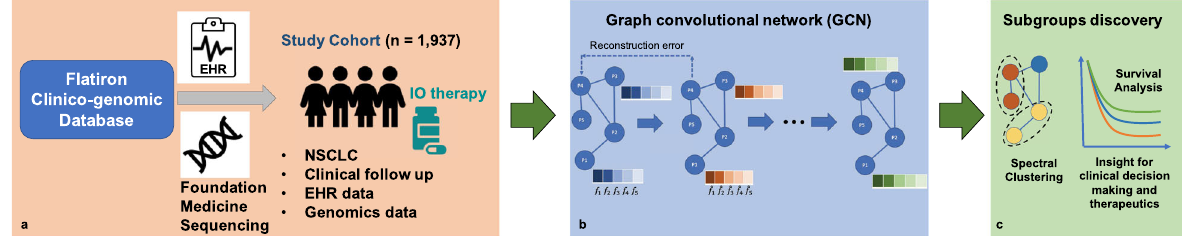
Fig. 1 The conceptual “ DeePaN ” framework as a deep patient graph convolutional network integrating electronic health records and genomics to strategy NSCLC patients bene fi ting from immunotherapy. a An IO-treated NSCLC cohort ( N = 1937) was identi fi ed from Flatiron clinico-genomic database with linked EHRs and genomics data. The clinical and genomic features are preprocessed (see “ Methods ” section for details) and concatenated as raw patient-data representations. b The raw patient-data representations are modeled by a deep patient graph convolutional network (GCN) implemented as the marginalized graph autoencoder (MGAE) to learn latent patient representations. In GCN modeling, patients are represented as nodes, and patients with similar clinico-genomic features are linked by edges. Multiple layers of graph convolutional network are stacked to learn latent patient representations, with each layer of the graph neural network being trained to produce a high-level patient-data representation from the output of the previous layer. c The graph-based deep patient representations are then subjective to spectral clustering to discover patient subgroups with distinct immunotherapy outcomes to inform precision-oncology including patient strati fi cation by IO bene fi